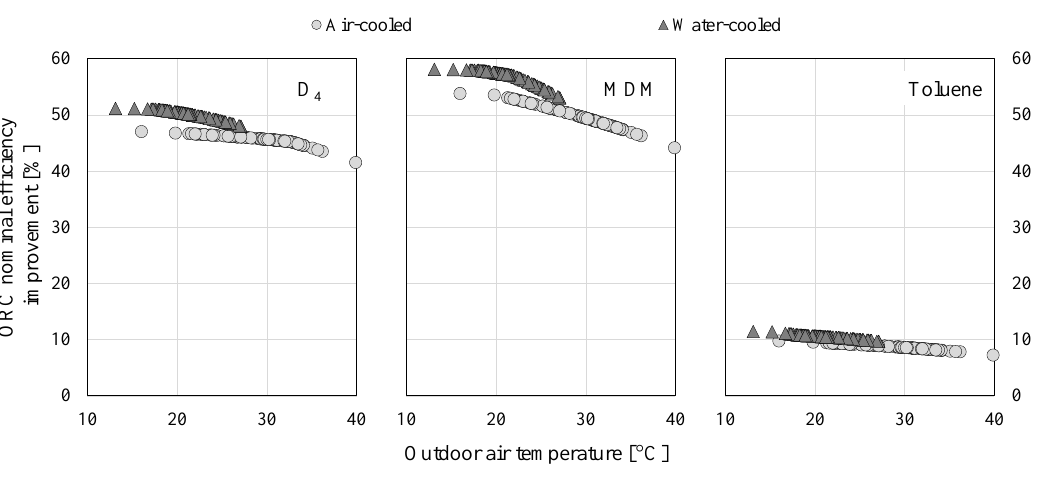
Figure 9. Impact of regenerator on ORC nominal efficiency.